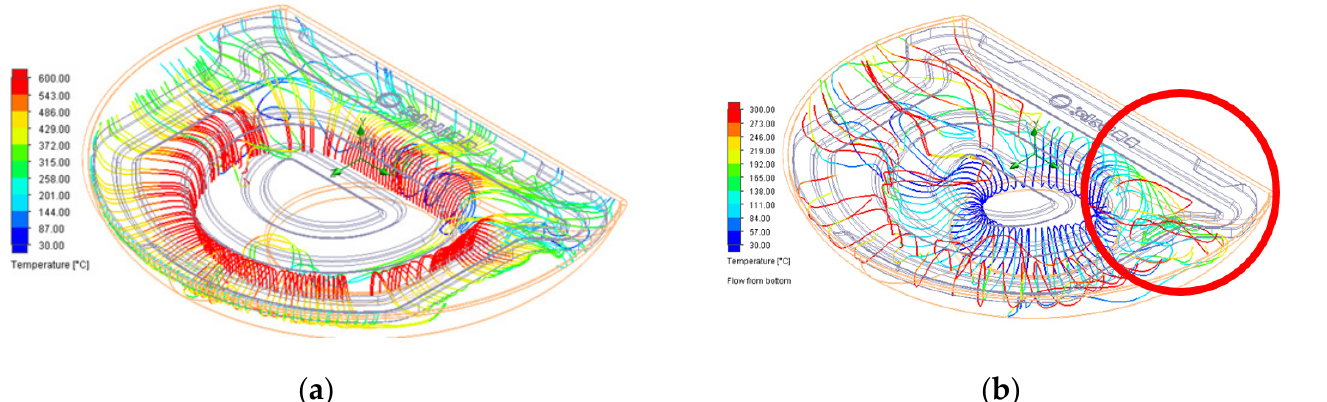
Figure 6. Original combustion system analysis ( a ) Burner streamline distribution (temperature); ( b ) Air inlet streamline distribution (temperature).